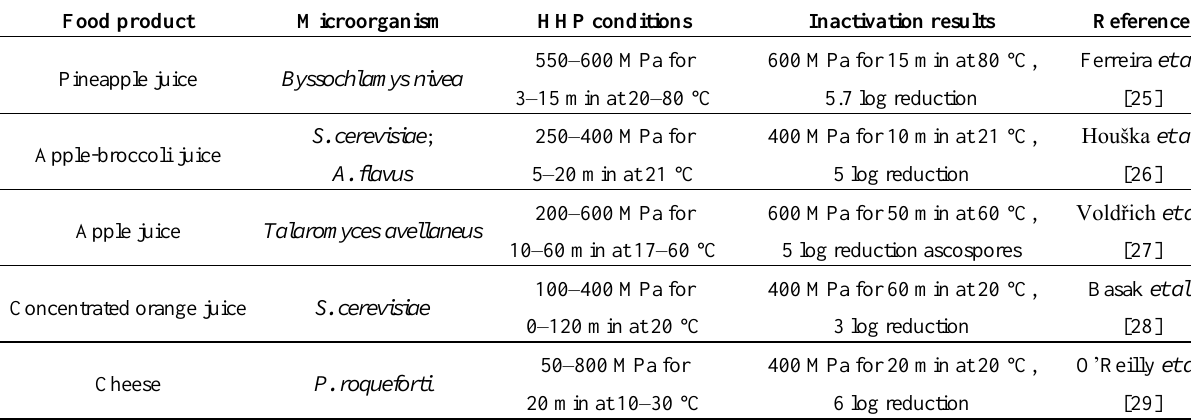
Table 2. High hydrostatic pressure (HHP) inactivation of molds and yeasts in different foods.